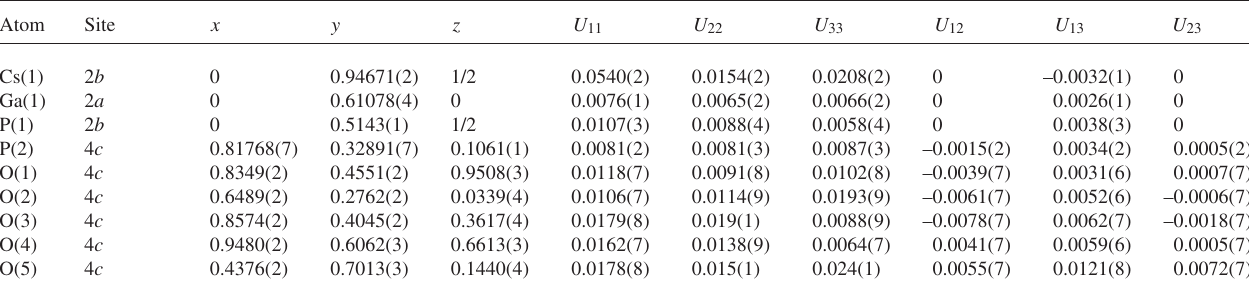
Table 3. Atomic coordinates and displacement parameters (in Å 2 ) .